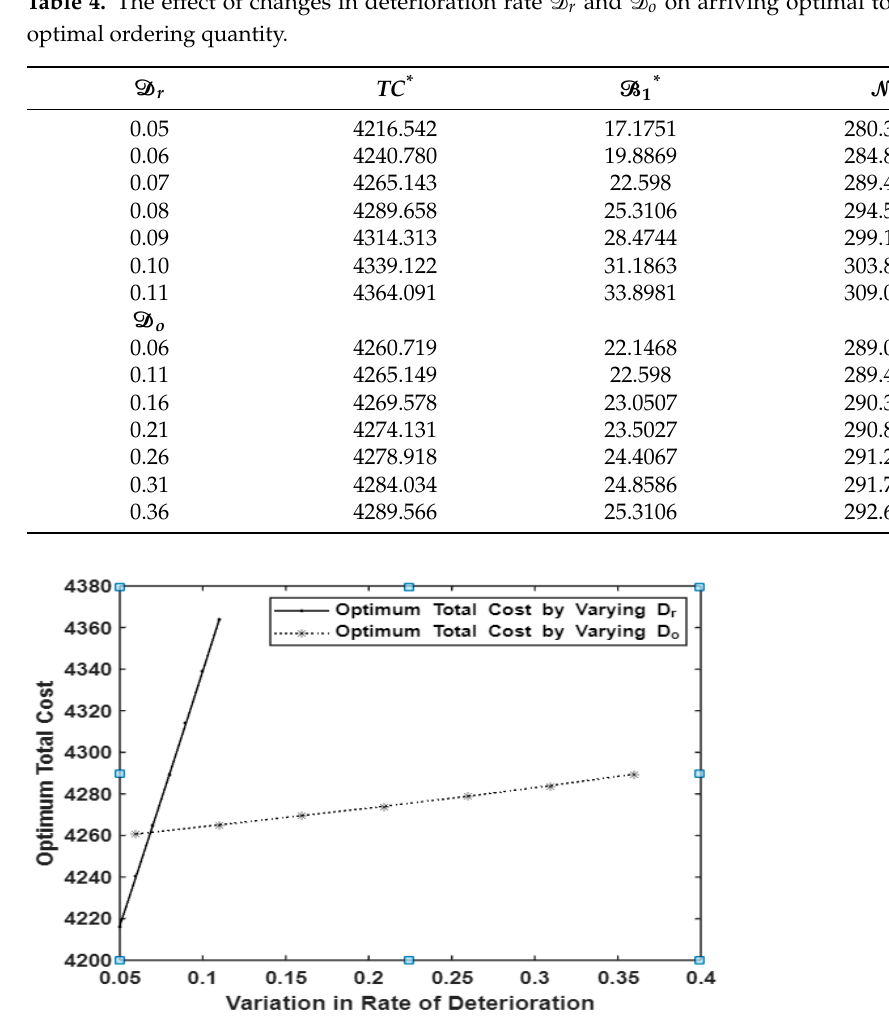
Figure 8. The effect of changes in deterioration rates 𝒟 (cid:3045) and 𝒟 (cid:3042) on optimal total cost.